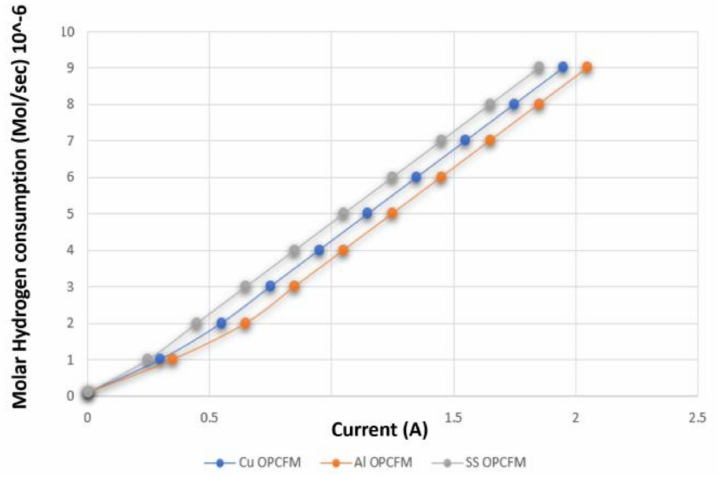
Figure 16. Hydrogen consumption for Al, Cu and SS OPCFM flow plate